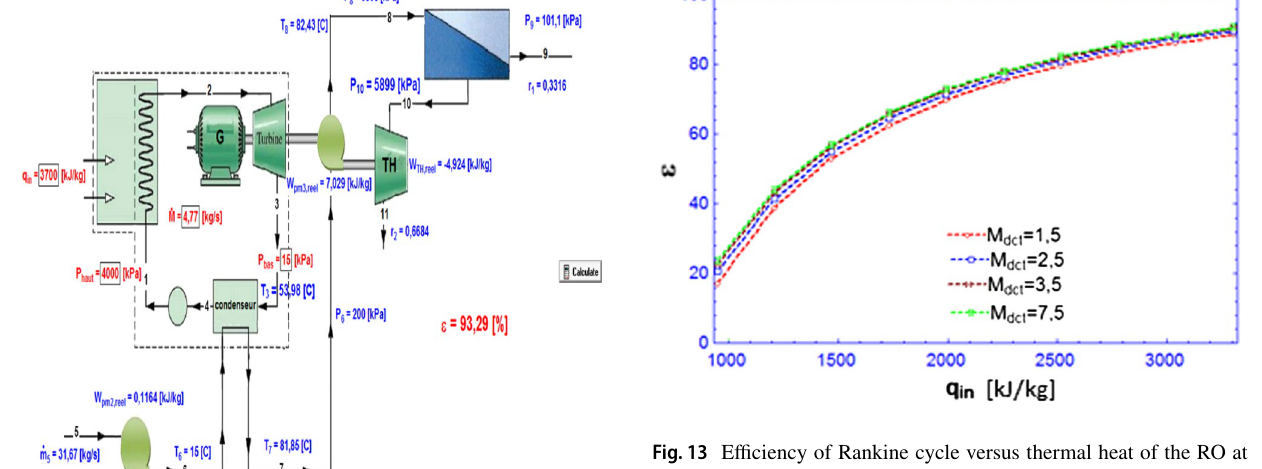
Fig. 13 Efficiency of Rankine cycle versus thermal heat of the RO at different pressures and flow rates of